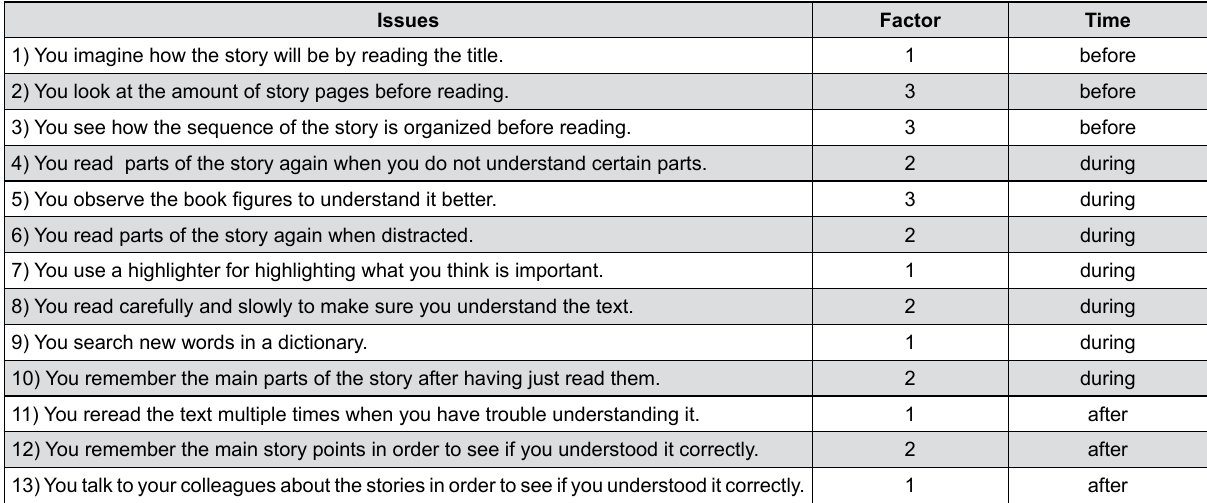
Figure 1- Strategy range of reading issues and their classification according to factor and